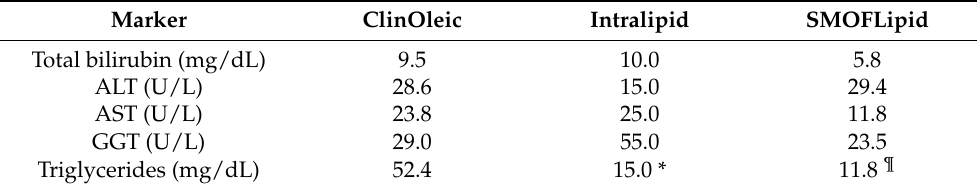
Table 6. Percentage of patients in each group with plasma liver function markers and triglycerides above the normal range.